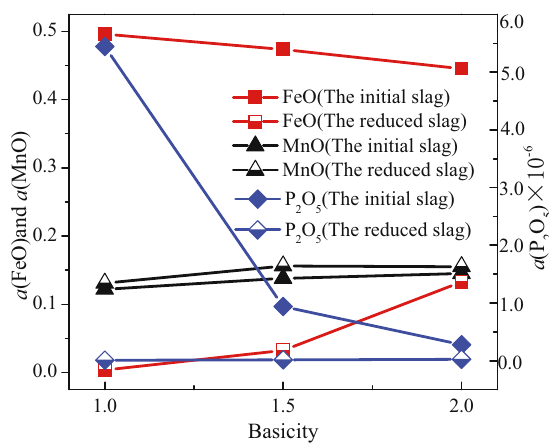
Figure 6: The activity of FeO, P 2 O 5 , and MnO before and after experiments.